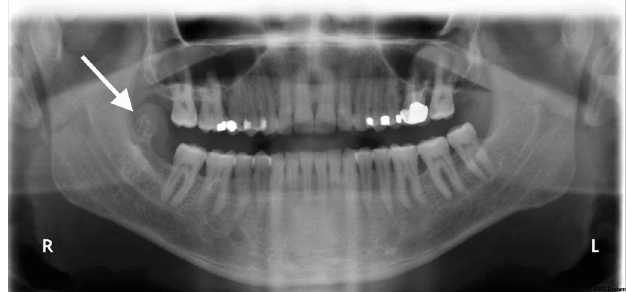
Fig. 2. Panoramic X-ray: solitary pedunculated osteoma, well-de fi ned, appearing as a radio-opaque mass in the right retromolar area.